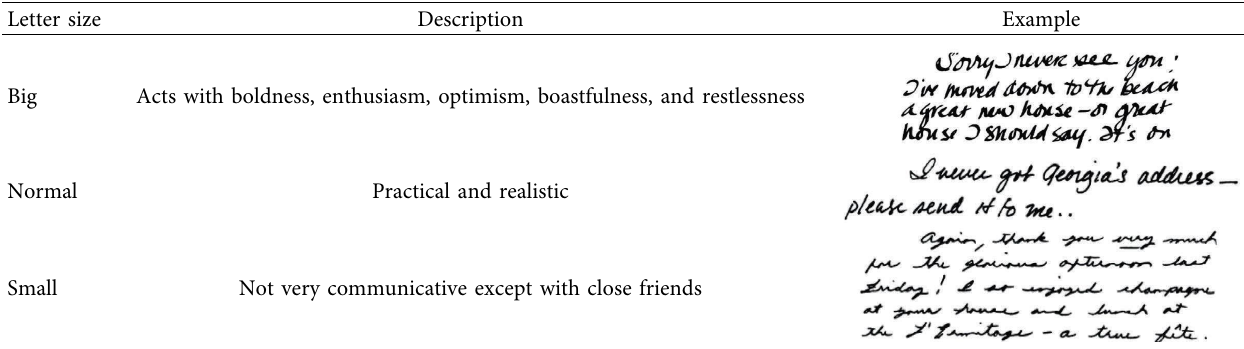
Table 3: Te letter size features and their corresponding types.